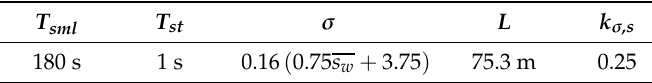
Table A1. Parameters used for the generation of wind speed signals.